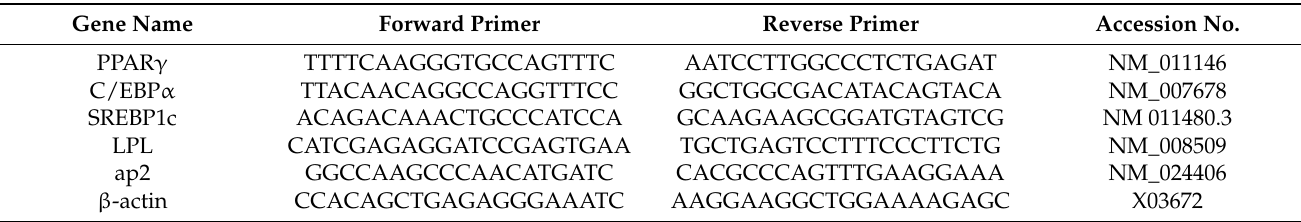
Table 1. The gene sequence of each primer.